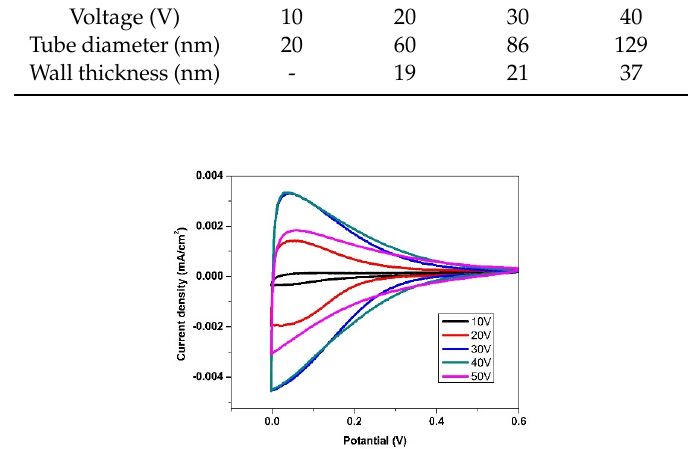
Table 1. Morphological parameters of the TNTs at di ff erent anodization voltage. Table 2. Tube length as a function of anodization time.